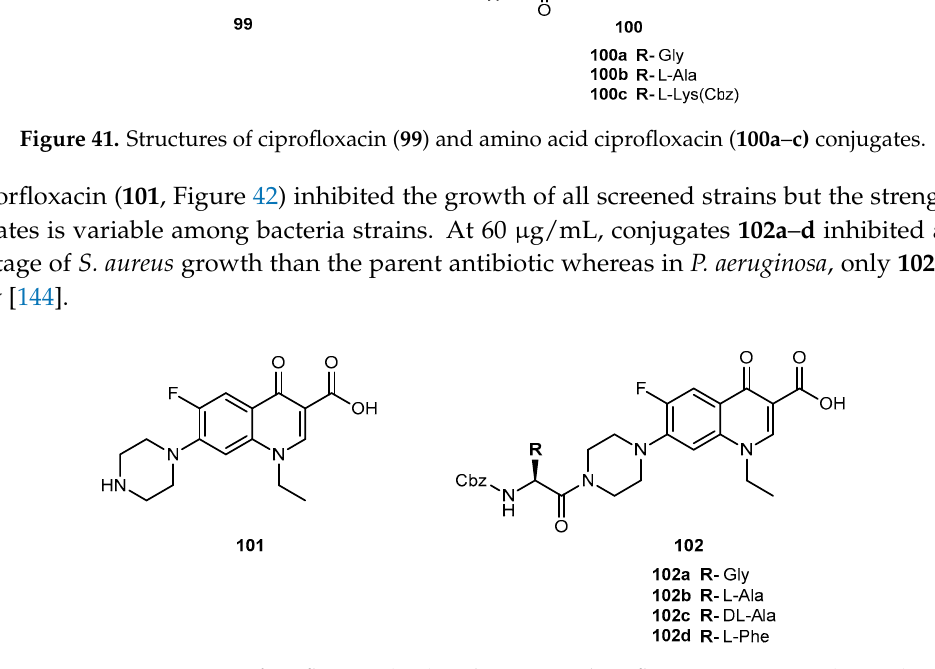
Figure 42. Structures of norfloxacin ( 101 ) and amino acid norfloxacin conjugates ( 102a – c ).